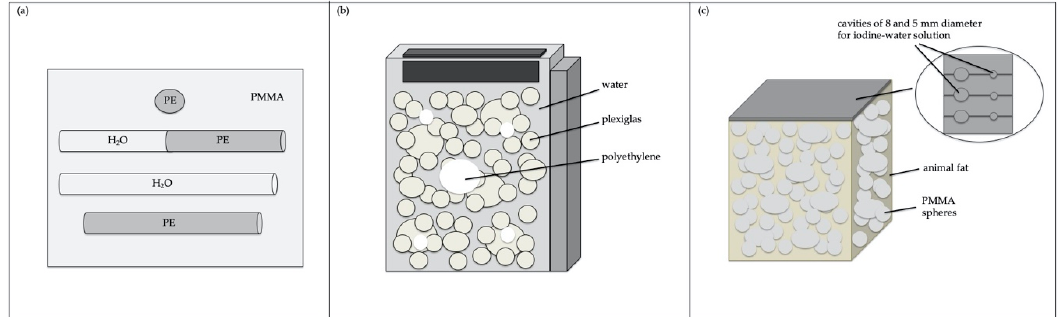
Figure 1. Schematic representation of phantoms used in the experimental studies [22,34,56,60]; ( a , b ) The phantoms represent tumor-like lesions; ( c ) iodine concentration for dual energy contrast enhanced mammography technique.